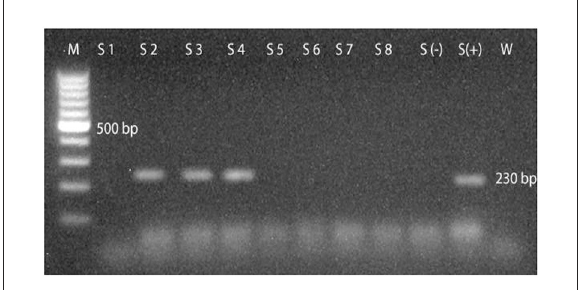
FIGURE7 Cucumber in tomato seeds mosaic view of the RT-PCR test result applied for cucumovirus on the gel imaging